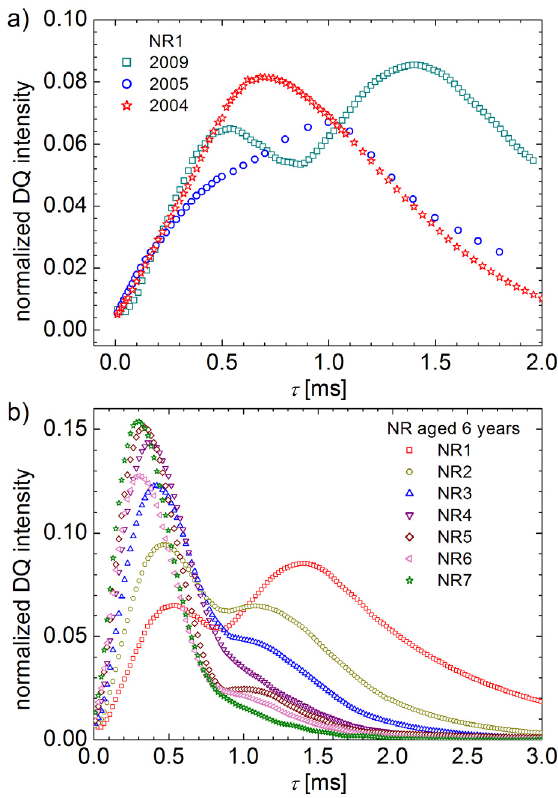
Figure 1. ( a ) Normalized 1 H DQ build-up curve for natural aged cross-linked natural rubbers measured after one year, two years and six years from the production date. ( b ) 1 H DQ build-up curves measured after six years after production as function of cross-link density (samples NR1 to NR7 from Table 1).